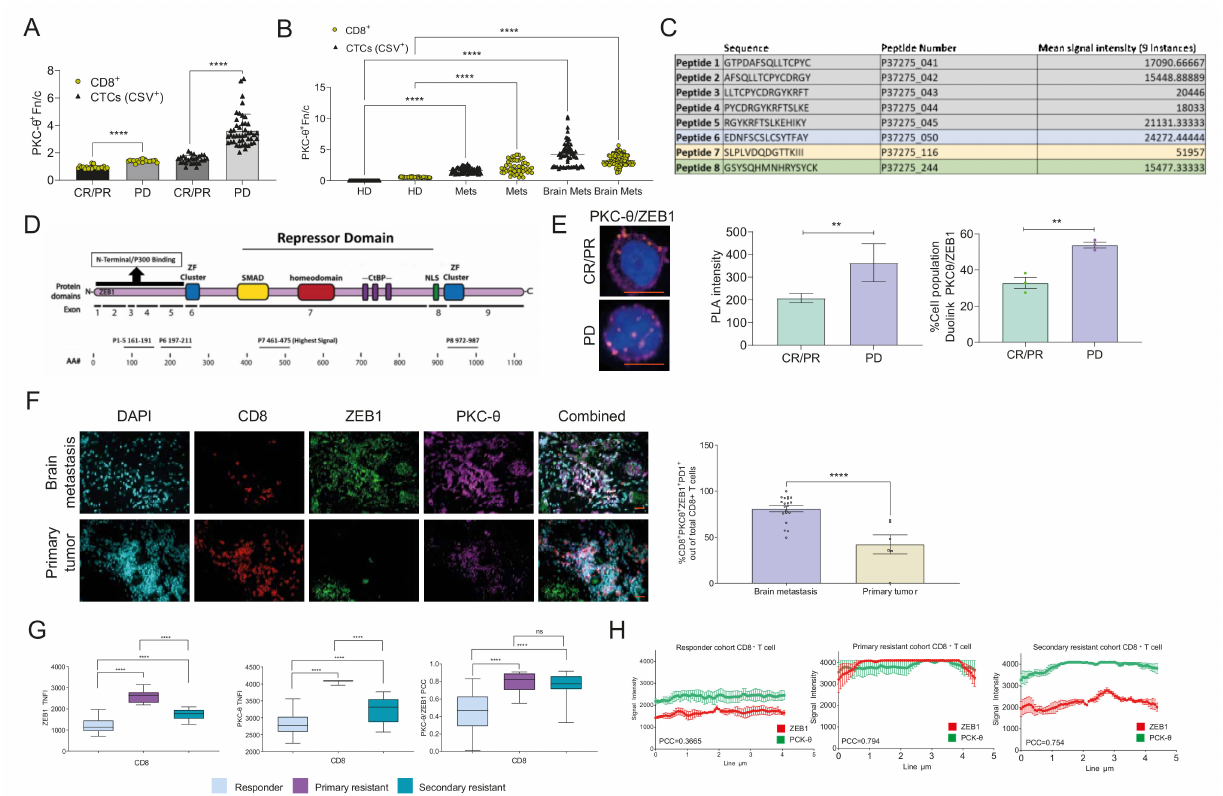
Figure 6. PKC- θ is enriched in the nuclei of dysfunctional CD8+ T cells isolated from stage IV metastatic cancers. ( A ) Quantification of PKC- θ -Thr568p Fn/c in CD8+ T cells or CSV+ CTCs isolated from immunotherapy-responsive (complete response, CR; partial response PR) or resistant (PD, pro- gressive disease) melanoma patients defined using RECIST 1.1 criteria. The Fn/c for PKC- θ -Thr568p was quantified by ASI digital pathology and ImageJ-Fiji ( n ≥ 20 cells per group). ( B ) Quantification of PKC- θ -Thr568p Fn/c in CD8+ T cells or CSV+ CTCs isolated from healthy donors (HD), stage IV metastatic breast cancer patients (Mets), or stage IV breast cancer patients with brain metastases (Brain Mets). The Fn/c for PKC- θ -Thr568p was quantified by ASI digital pathology and ImageJ-Fiji ( n ≥ 40 cells per group). ( C ) The amino acid sequence of ZEB1 indicating the top eight peptides for peptide phosphorylation by PKC- θ . The top peptide sequences are displayed in a table with the mean signal intensity (2 SD above the mean was considered a positive phosphorylation event). ( D ) Top peptides positive for phosphorylation and their overlap with the ZEB1 amino acid sequence as well as the structure of ZEB1, adapted from [3]. ( E ) Duolink ® proximity ligation assay (PLA) for PKC- θ and ZEB1 in CD8+PD1+ T cells isolated from immunotherapy-resistant or responder melanoma patients. Representative images are shown for PKC- θ /ZEB1, scale bar represents 10 µ M. Graphs represent